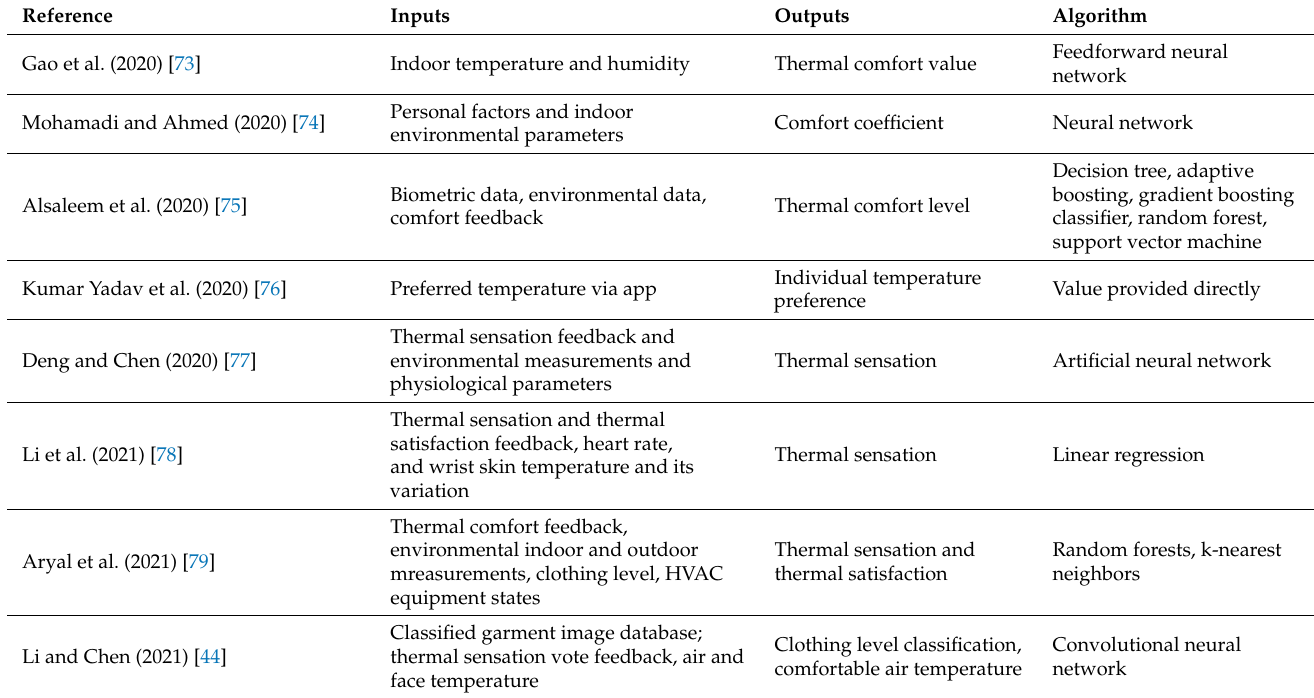
Table 6. Data-driven thermal comfort models in reviewed journal articles